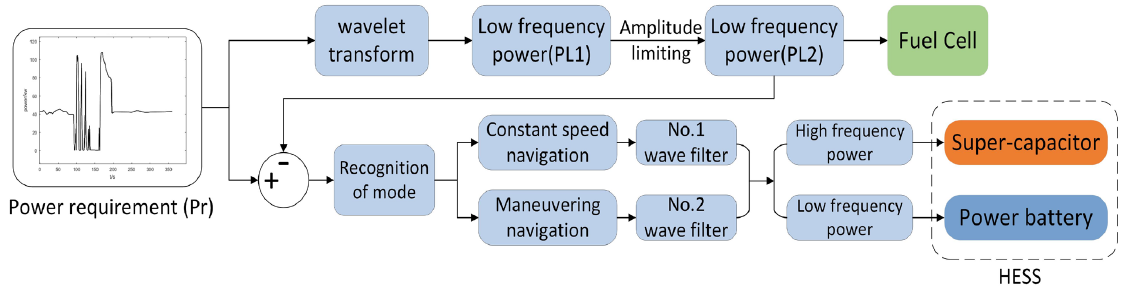
Figure 2. Energy management strategies for fuel cell ships.